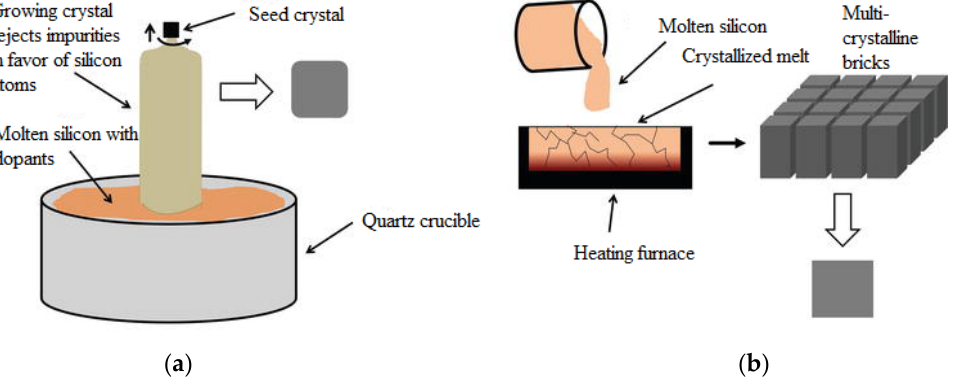
Figure 4. A picture showing ( a ) the Czochralski process for monocrystalline blocks and ( b ) the process of directional solidification for multicrystalline blocks [21].